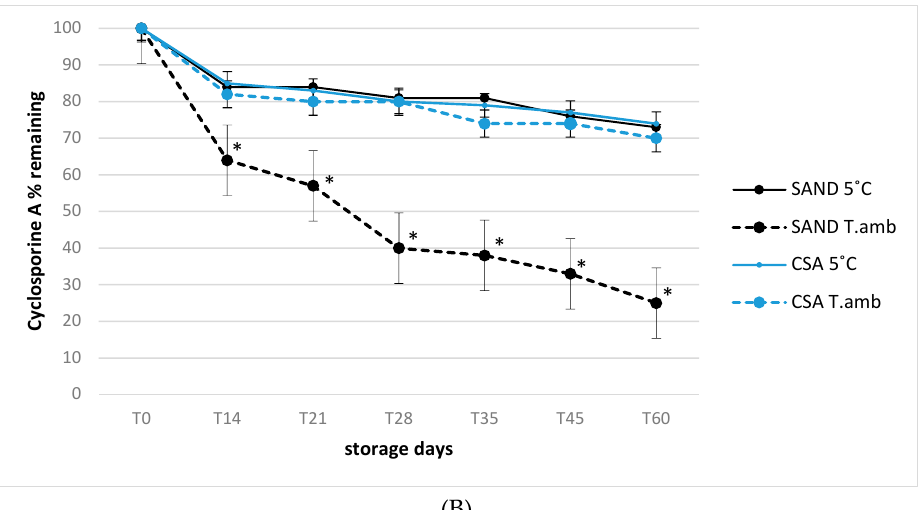
Figure 2. ( A ) Active principle stability in 0.1% tacrolimus (A) eye drops formulations stored at 5 °C and 25 °C (T.amb) under user simulated conditions (see Experimental for details); * p < 0.05, T.amb versus 5 °C storage temperature. ( B ) Active principle stability in 1.0% cyclosporine A (B) eye drops formulations stored at 5 °C and 25 °C (T.amb) under user simulated conditions (see Experimental for details); * p < 0.05, T.amb versus 5 °C storage temperature.